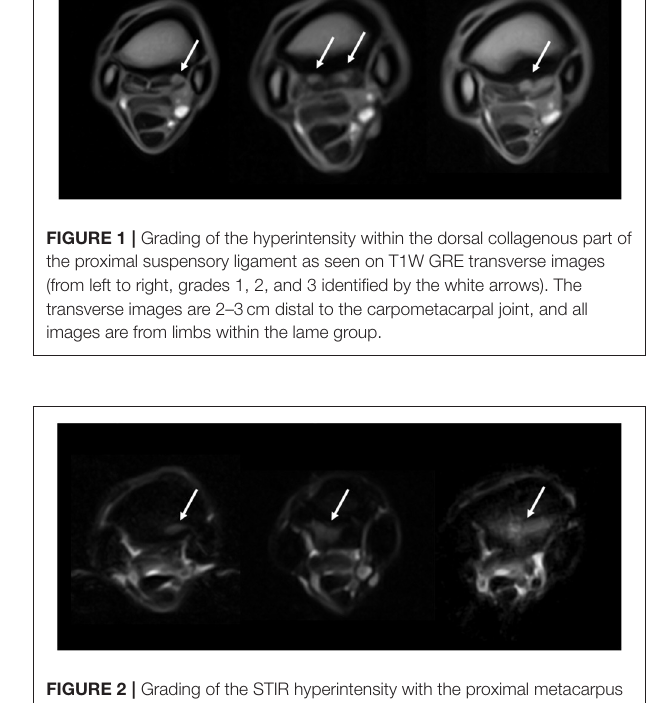
FIGURE 2 | Grading of the STIR hyperintensity with the proximal metacarpus as seen on STIR FSE transverse images (from left to right, grades 1, 2, and 3 identified by the white arrows). The transverse images are located 1–2cm distal to the carpometacarpal joint, and all images are from limbs within the lame group.